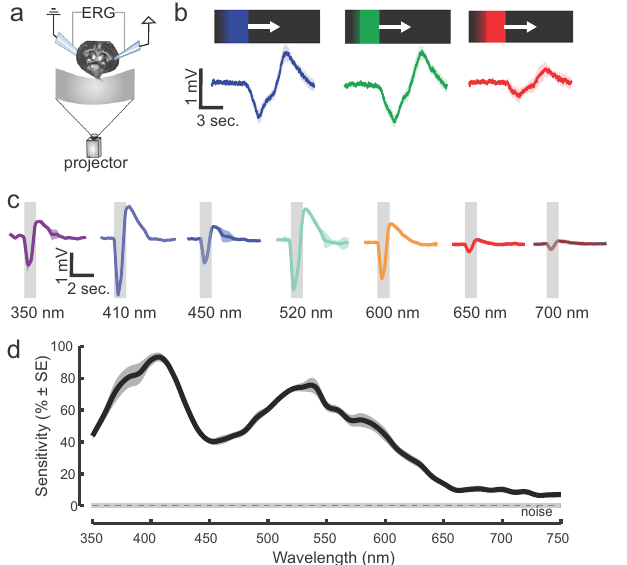
Fig. 4 Retinal sensitivity to visual stimuli. a Experimental setup for the electroretinogram (ERG) experiments. b ERG responses to a blue (410nm), green (520 nm) or red (>590 nm) moving bar (mean ± sem; n = 7 mosquitoes). Responses to the moving object were signi fi cantly higher than the baseline for all tested dominant wavelengths (410nm, 520 nm or 590 nm), although 410 nm and 520nm bars elicited stronger responses (Kruskal – Wallis test, Amplitude responses~wavelength moving bar, df = 2, Chi-sq. = 40.03, P < 0.001, n = 7 mosquitoes). c ERG responses to pulses of light (350 – 750 nm). Traces are the mean responses (shaded area is the ±sem; n = 8 mosquitoes) to discrete wavelengths showing the elevated responses to 410 nm (violet to human observer) and 520 nm bands. d Retinal sensitivity curve across the tested wavelengths from 350 to 750 nm. Two maxima occurred at the short (420 nm) and medium (~530 nm) wavelengths, although responses were still signi fi cantly elevated above the noise at wavelengths more than 650 nm (two-sided t -test, ERG vs. noise: P < 0.01).